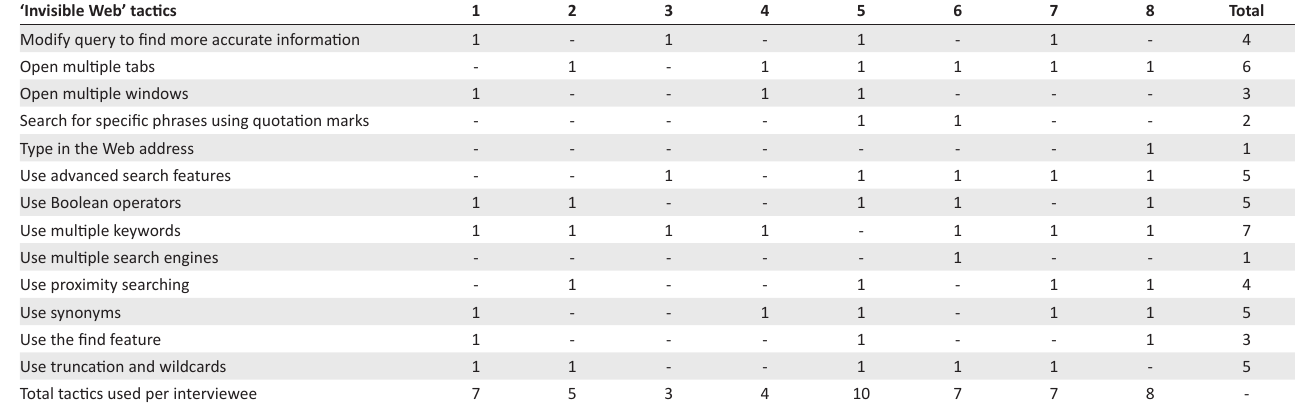
TABLE 4: Web search strategies using the ‘invisible